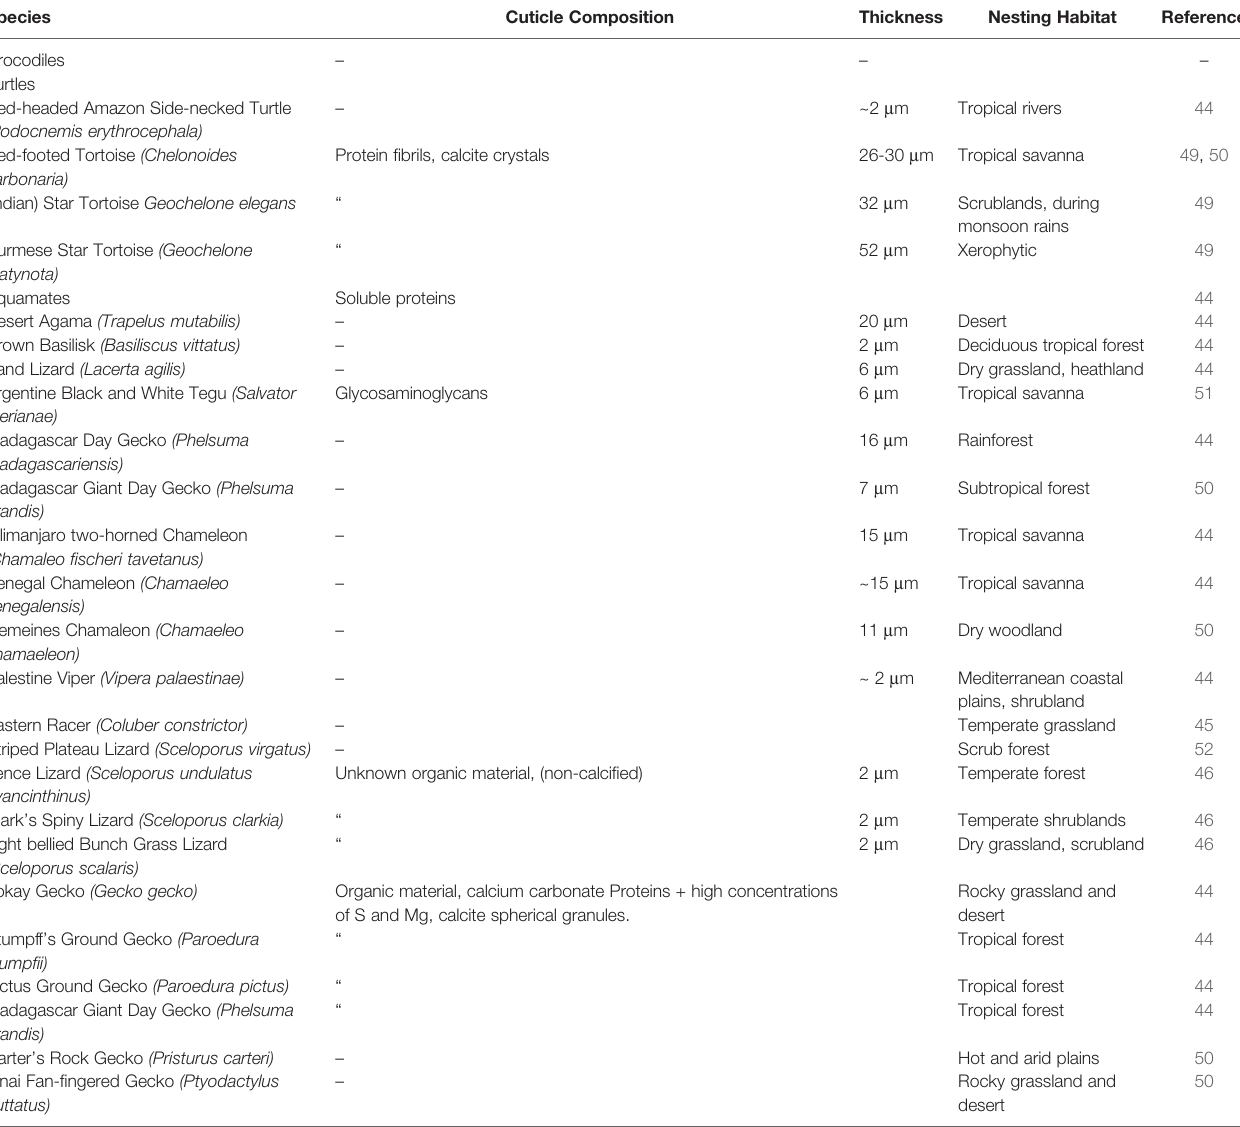
TABLE 1 | Published reports of eggshell cuticle in non-avian reptiles and information on cuticle composition and speci fi c nesting